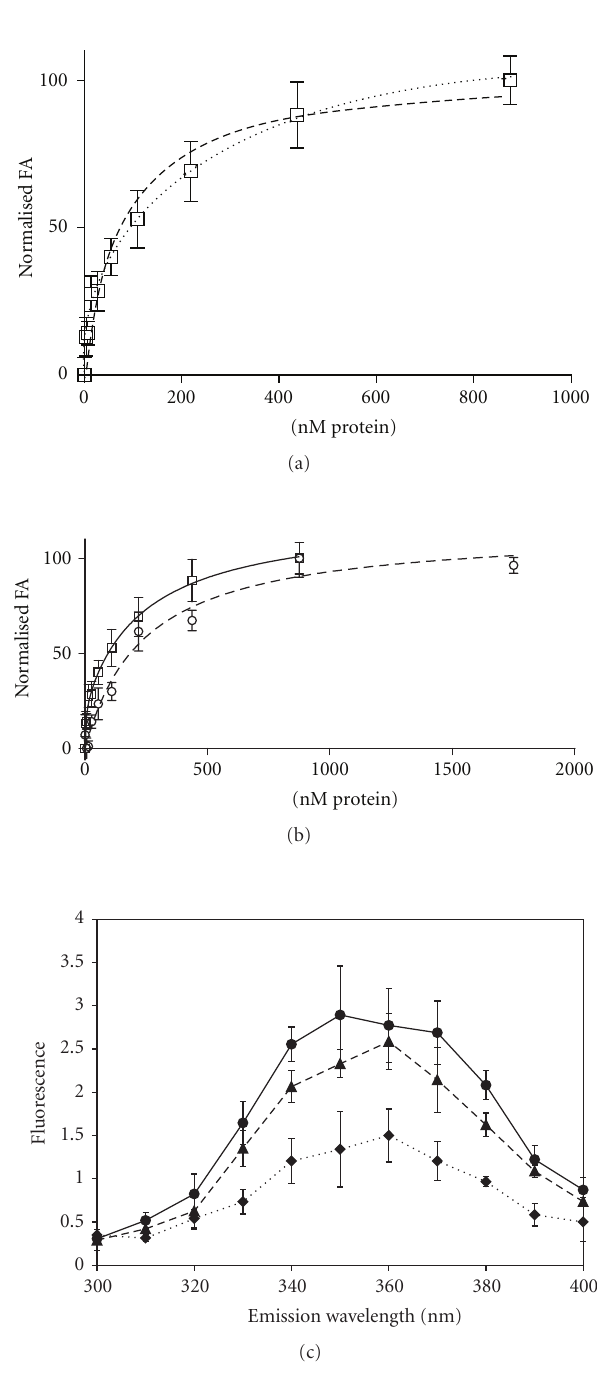
Figure 6: (a) Comparison showing the improved fit of a two- site binding model (dotted line) versus the Hill binding model employed for analysis (dashed line) for the HvRPA3-NTD dimer in 1M KCl. The x axis displays the concentration of the dimer with the y axis indicating normalised FA. (b) Comparison of binding of dimeric HvRPA3-NTD in 1M (solid line) fitted to the two-site model displayed in (a) and the monomeric form in 3 M (dashed line) KCl fitted to a Hill binding model. The x axis displays the concentration of the proteins with the y axis indicating normalised FA. (c) Intrinsic fluorescence spectra for HvRPA3-NTD incubated in 0.2 (dotted line), 1M (dashed line), and 3M (solid line) KCl. The x axis shows the wavelength of the emission spectra (nm) and the y axis the observed